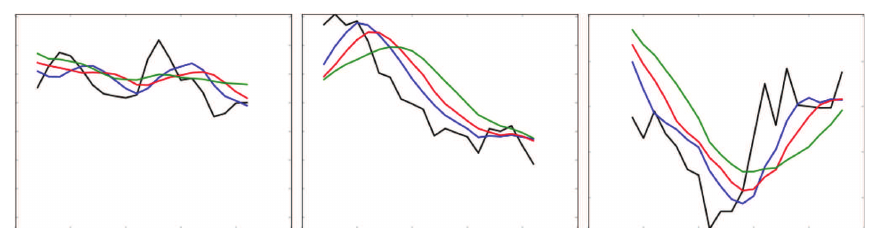
Figure 20: Experiment 1 with Label